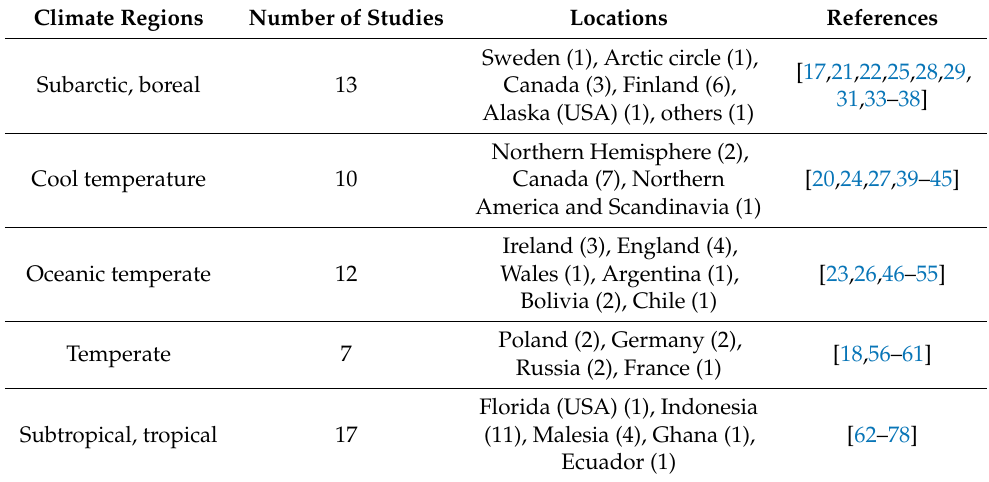
Figure 1. Cumulative number of reviewed studies during 2010–2021 and dates of launching selected satellite remote sensing systems (prepared based on works provided in Supplementary Material, Table S1). Table 1. Geographic characteristics of reviewed studies (prepared based on works provided in the Supplementary Material, Table S2).